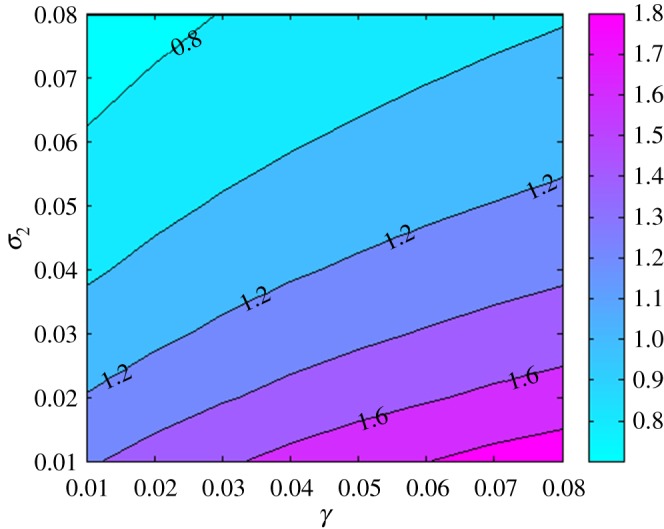
A contour plot to show how parameters σ2 and γ affect Rg.